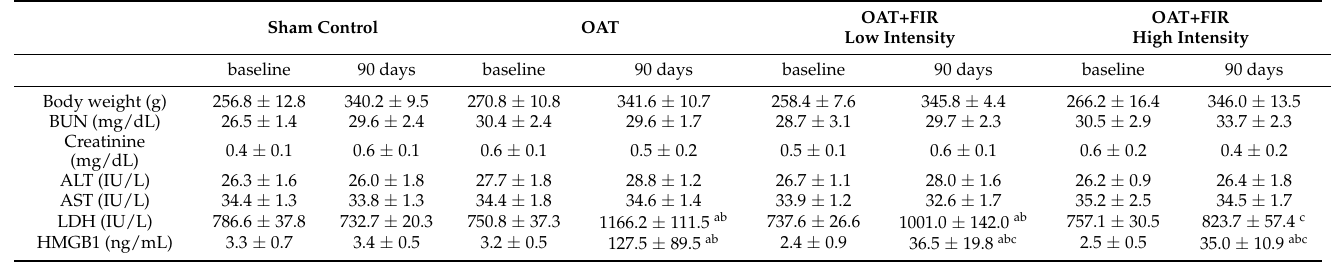
Table 2. Comparison of biochemical parameters in experimental ACI/NKyo rats ( n = 5).